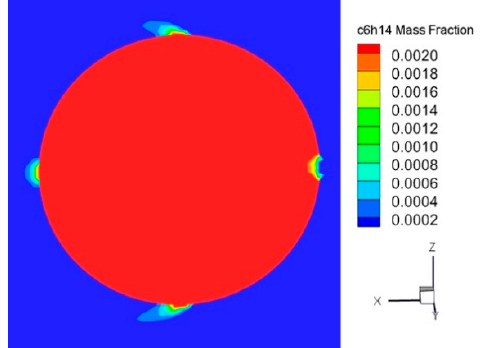
Figure 17. Distribution of n-hexane-vapor concentration (mass fraction) near the vents.